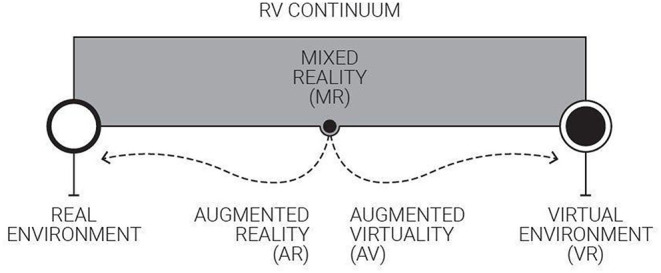
Diagram of the Reality-Virtuality (RV) continuum. Adapted from Milgram and Colquhoun (1999).